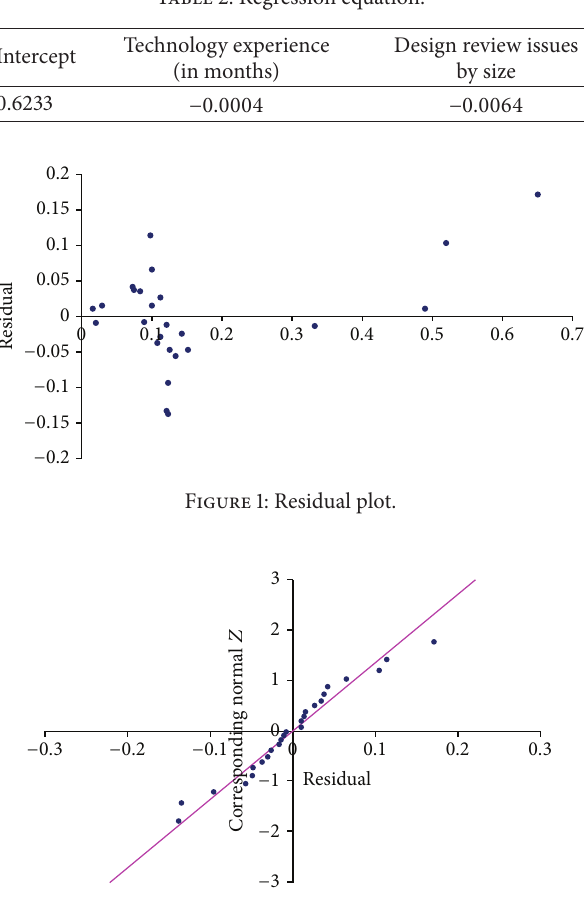
Figure 2: Normal probability